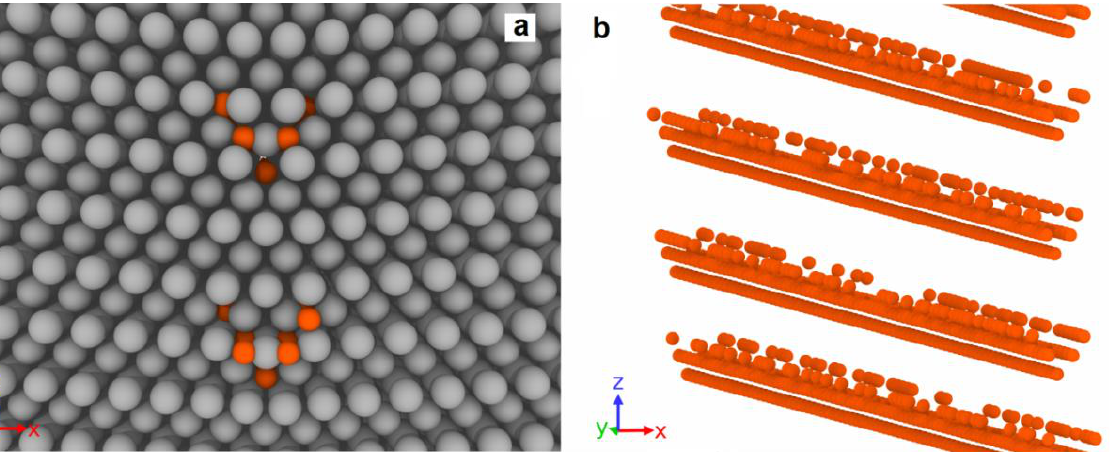
Figure 3. Initial view of the system with five columns of Cu atoms located near each pentagonal void at GB. The fourth and fifth columns of Cu atoms are 15% filled. ( a ) xz -plane of system; ( b ) perspective view of Cu columns. Grey circles are Al atoms, orange — Cu atoms. Table 1. Mechanisms of plastic relaxation and characteristic stresses for systems with different Cu content.